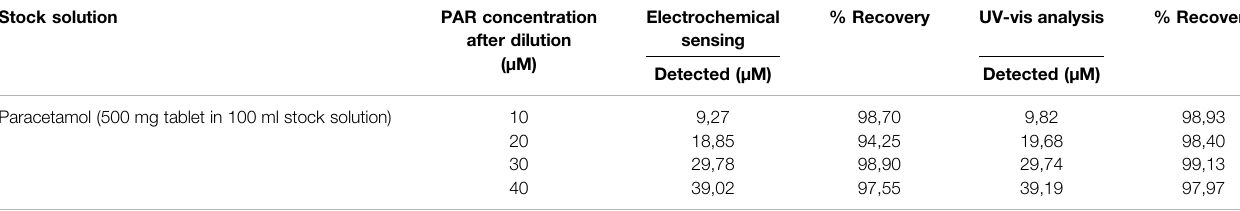
TABLE 2 | Recovery rates of commercial PAR samples in 0.1M PBS using GCE-gCN-AgPVP. Stock